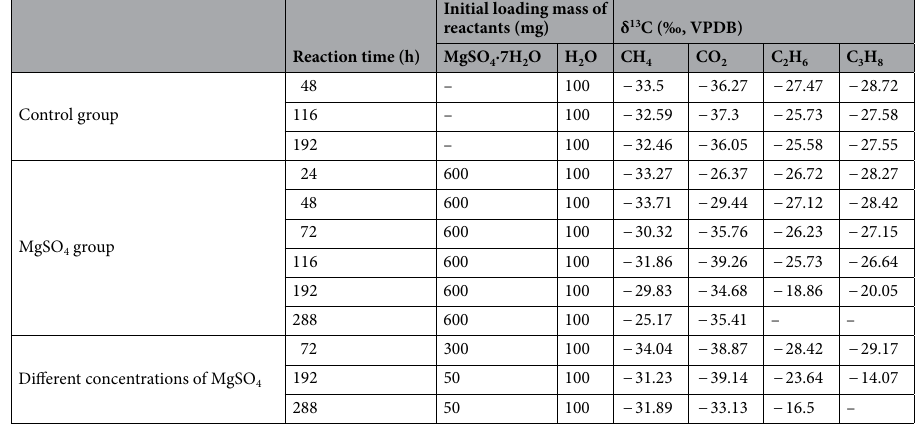
Table 3. Carbon isotopic compositions of gas products in hydrothermal pyrolysis of different experimental conditions.